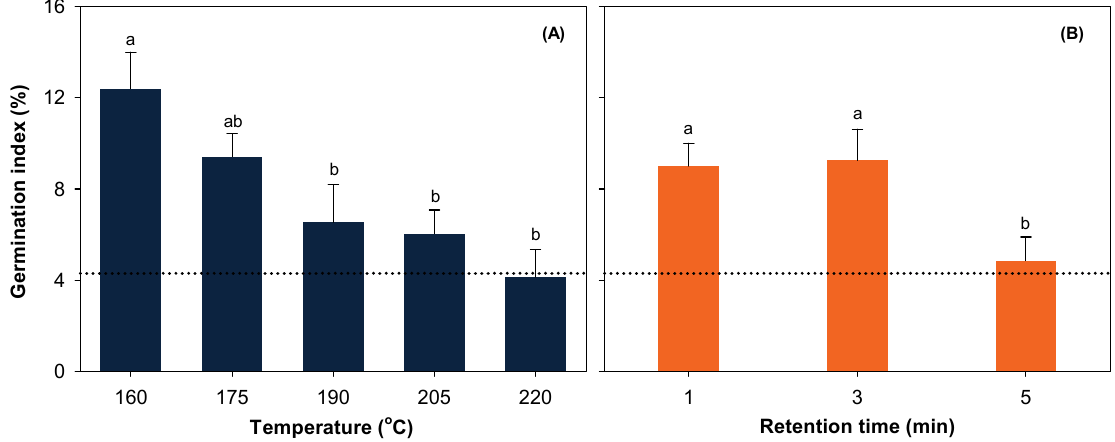
Figure 1. Germination index as affected by main effects of temperature ( A ) and retention time ( B ). Data represents mean ± SE. The dotted line represents untreated control. Means followed by different lower-case letters indicate significant differences among temperatures or retention times at α = 0.05.